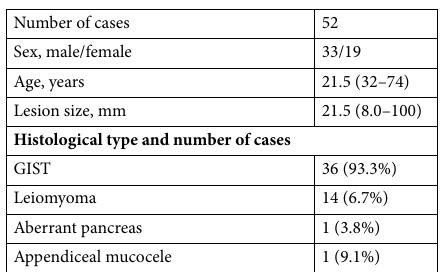
Table 1. Patient and lesion characteristics for test cases. Values are presented as n, n (%), or median (range). GIST, gastrointestinal stromal